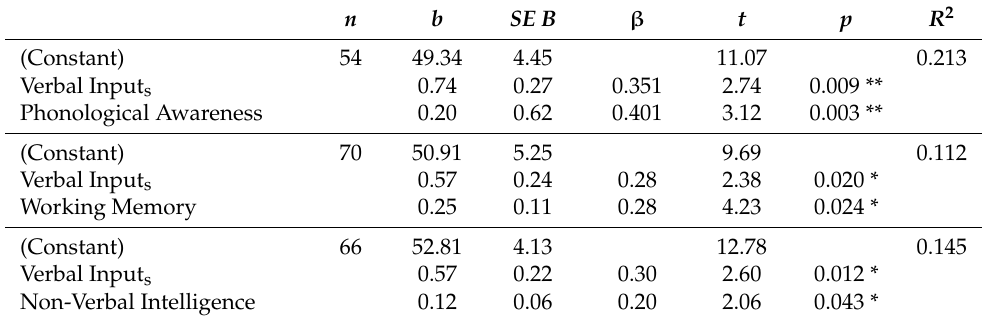
Table 3. Regression analysis with verbal input (VI s ) and single cognitive skills as independent variables, ELIAS Grammar Test 2 (EGT 2) as a dependent variable.